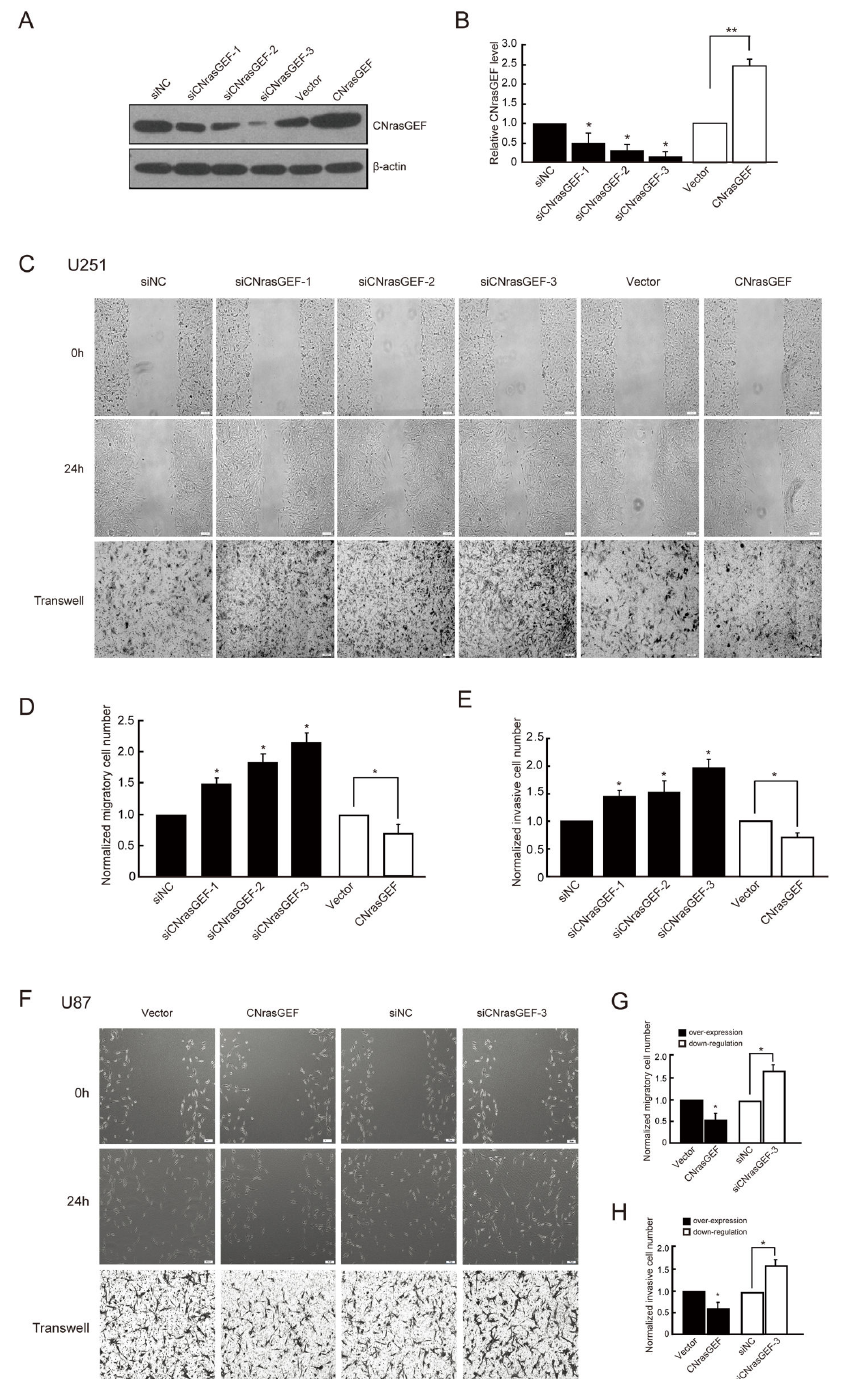
Figure 3. The effect of CNrasGEF on cell migration and invasion. A) Representative western blotting analysis of CNrasGEF knocking-down or overexpression efficacy in U251 glioma cells. B) Quantitative analysis of relative protein levels of CNrasGEF normalized to those of β-actin. C) Wound-healing assay (up and middle panel) and transwell invasion assay (bottom panel) of glioma U251 cells transfected with siRNAs or overexpression of CNrasGEF. D & E) Quantitative analysis of the number of migratory (D) or invasive (E) cells. F) Wound-healing (up and middle panel) and transwell invasion assay (bottom panel) of glioma U87 cells after CNrasGEF downregulation or overexpression. G & H) Quantitative analysis of the number of migratory (G) or invasive (H) cells. Data were mean ± SEM of three independent experiments in triplicate. * P <0.05.Bar: 100 μm. doi: 10.1371/journal.pone.0082789.g003 PLOS ONE |